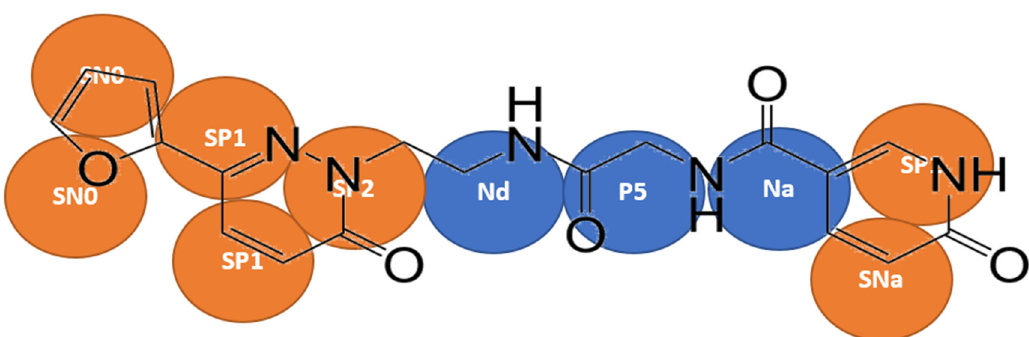
Figure 1. Coarse-grained mapping and bead assignments for Compound X . Ordinary MARTINI beads were coloured in blue and S MARTINI beads were coloured in orange.